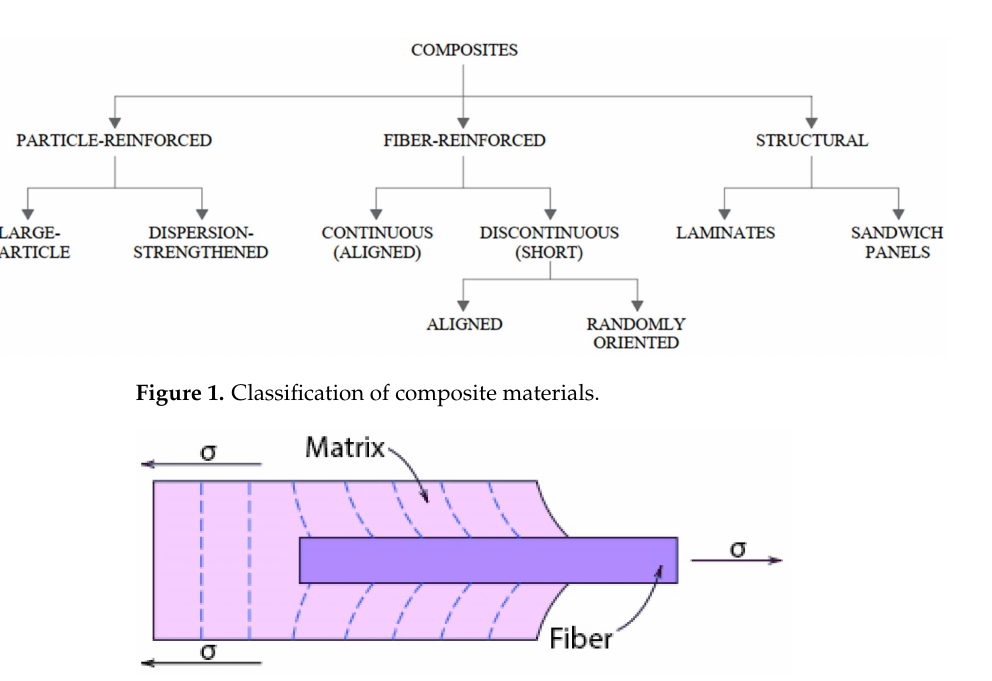
Figure 2. Deformation pattern in the matrix surrounding a fibre that is subjected to